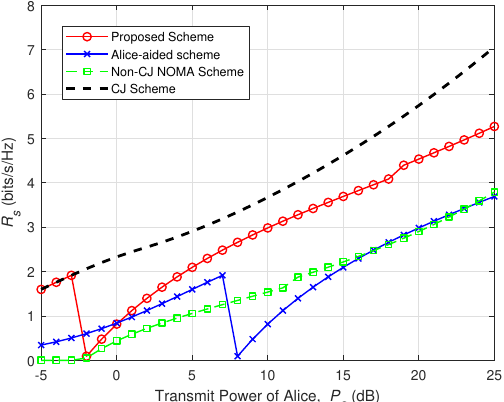
Figure 2. Secrecy rate R s vs. the transmit power of Alice P a .